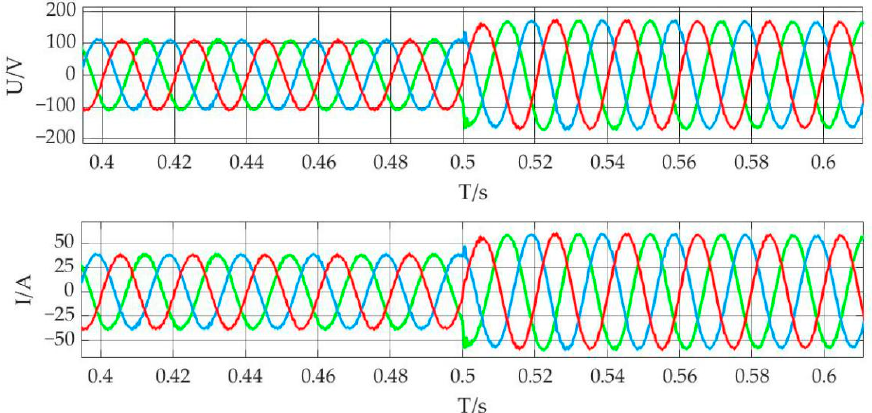
Figure 10. Voltage and current diagram of the first type isolated island of electric spring.